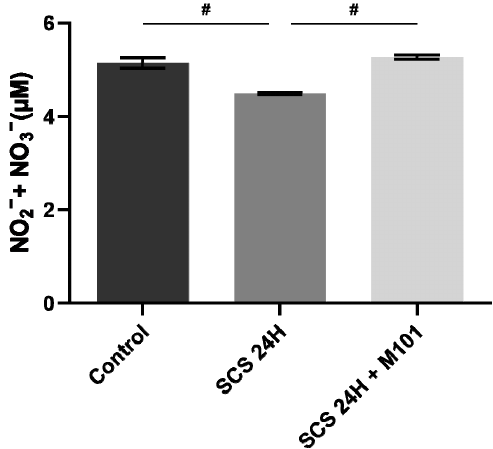
Figure 4. Nitrate/nitrite production decreased in the absence of M101. Nitrate and nitrite production was significantly decreased in the SCS-24H group after the 2 h reperfusion. Data are represented as mean (SEM). n = 12/group, # = p < 0.05 vs. SCS-24H (Mann–Whitney–Wilcoxon).